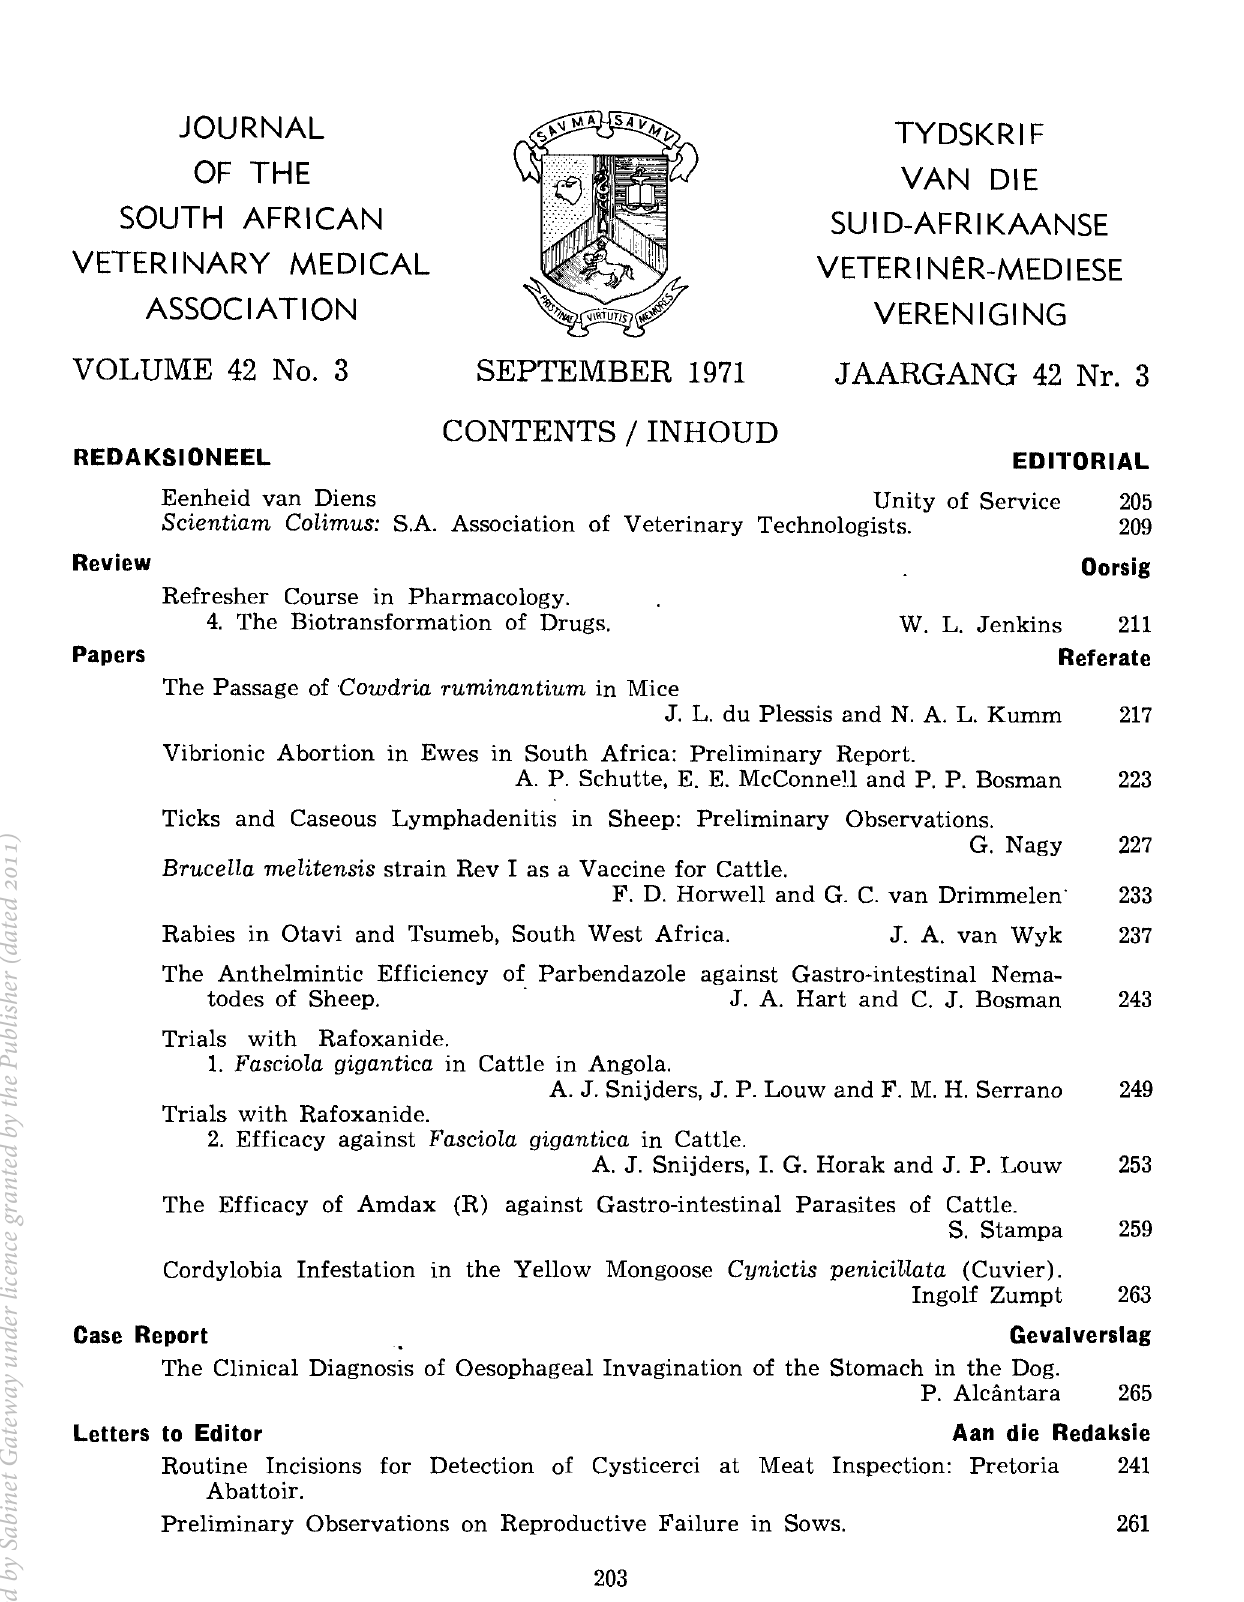
The Passage of Cowdria ruminantium in Mice Vibrionic Abortion in Ewes in South Africa: Preliminary Report. Ticks and Caseous Lymphadenitis in Sheep: Preliminary